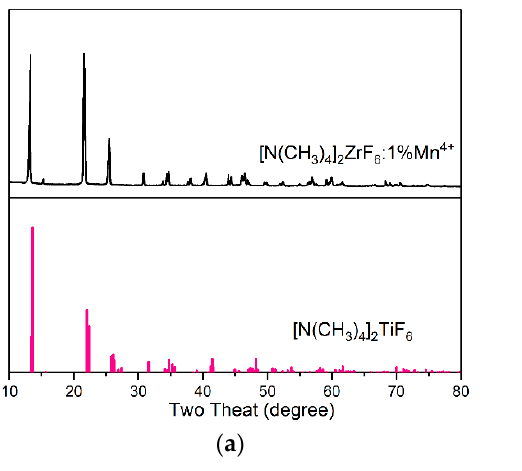
Figure 1. ( a ) XRD patterns of [N(CH 3 ) 4 ] 2 ZrF 6 :1%Mn 4+ sample (top) at room temperature, and a standard [N(CH 3 ) 4 ] 2 TiF 6 card (bottom) is given as a reference. ( b ) SEM image of [N(CH 3 ) 4 ] 2 ZrF 6 :1%Mn 4+